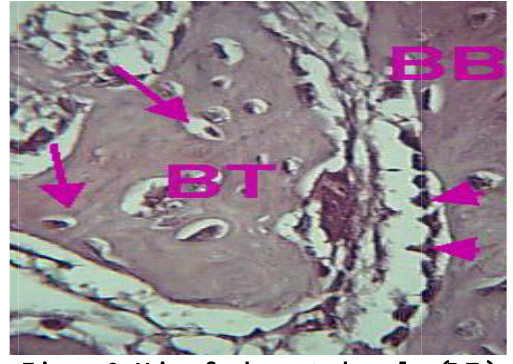
Figure 9: View for bone trabeculae (BT) occupies base of implant bed close to basal occupies base of implant bed close to basal bone (BB), osteoblast (arrow heads) rimming bone (BB), osteoblast (arrow heads) rimming bone and osteocyte (arrows) can be detected. bone and osteocyte (arrows) can be detected. Histological features The histological view of non coated titanium illustrate apposition of osteoid tissue of implantimpression nct threads as shown in